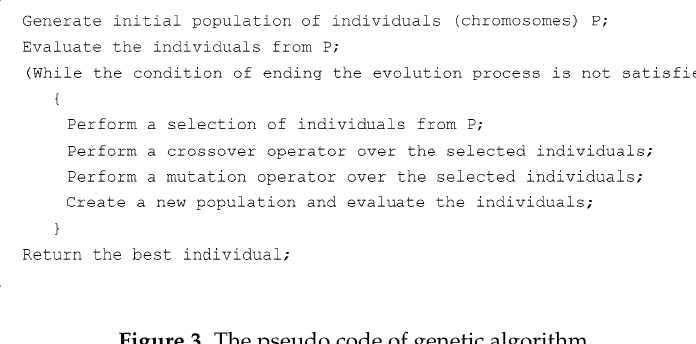
Figure 3. The pseudo code of genetic algorithm.